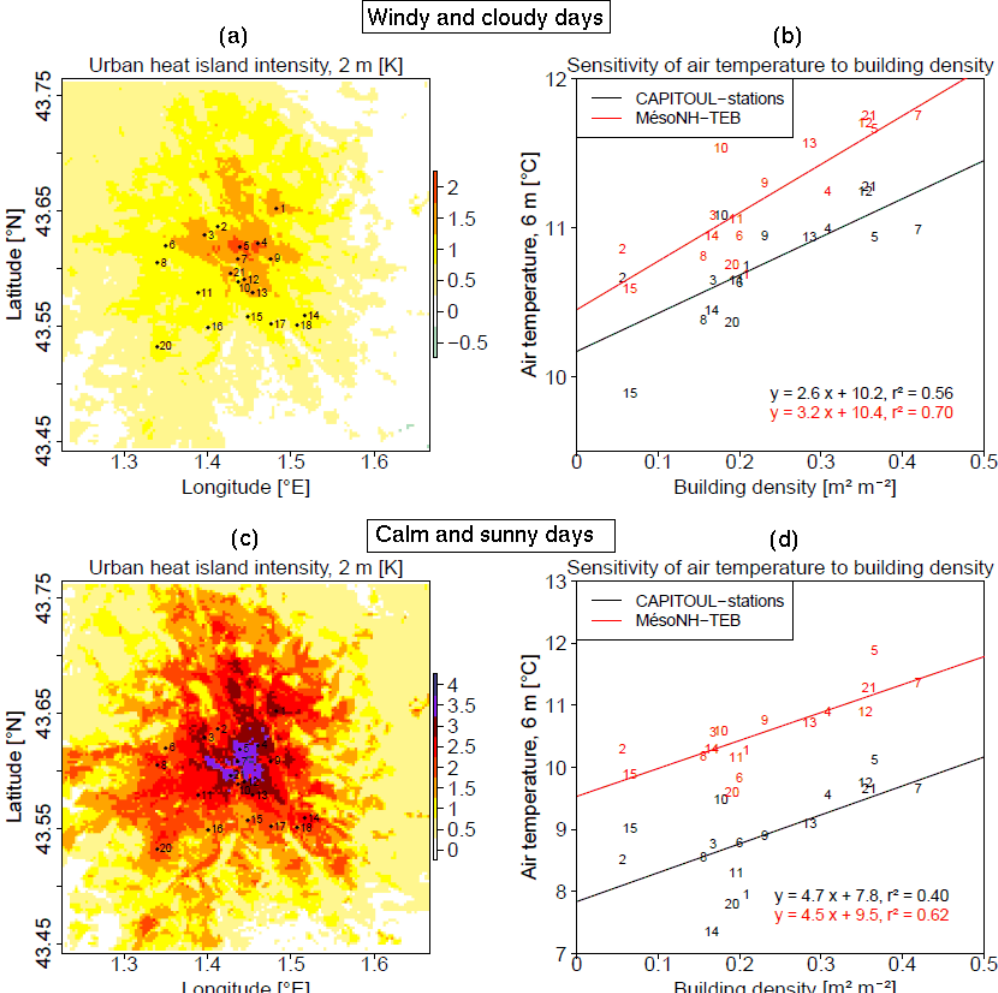
Figure 11. Sensitivity of the nocturnal (1 to 5 local solar time) near-surface air temperature on urbanization for a domain covering the agglomeration of Toulouse (France) at a horizontal resolution of 250m. Panels (a) and (c) show the difference in the 2m air temperature between a simulation taking the urbanization into account via TEB and a simulation without urbanization for all days during March, April, and May 2004 classed into (a) relatively windy and cloudy days and (c) calm and sunny days via the clusterization of Hidalgo et al. (2014). Panels (b, d) show the comparison between the values of the air temperature 6m above the ground simulated by Meso-NH–TEB and observed during the CAPITOUL campaign for the same two weather types. The locations of the stations are displayed in the left